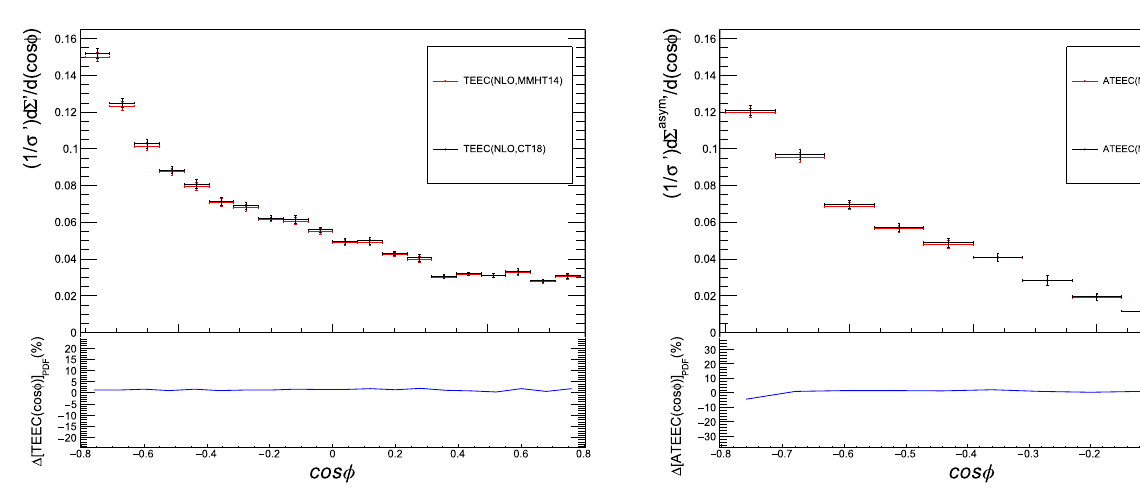
Fig. 2 Differential distribution 1 /σ (cid:7) d (cid:9) (cid:7) / d ( cos φ) and its asymme- try 1 /σ (cid:7) d (cid:9) (cid:7) asym / d ( cos φ) , calculated in Next-to-Leading order for the low- Q 2 range 5 . 5GeV 2 < Q 2 < 80GeV 2 for the ep center-of-mass